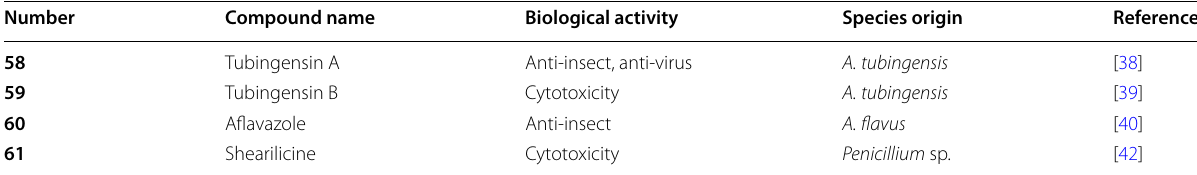
Table 5 Name, bioactivities and source of tubingensin A